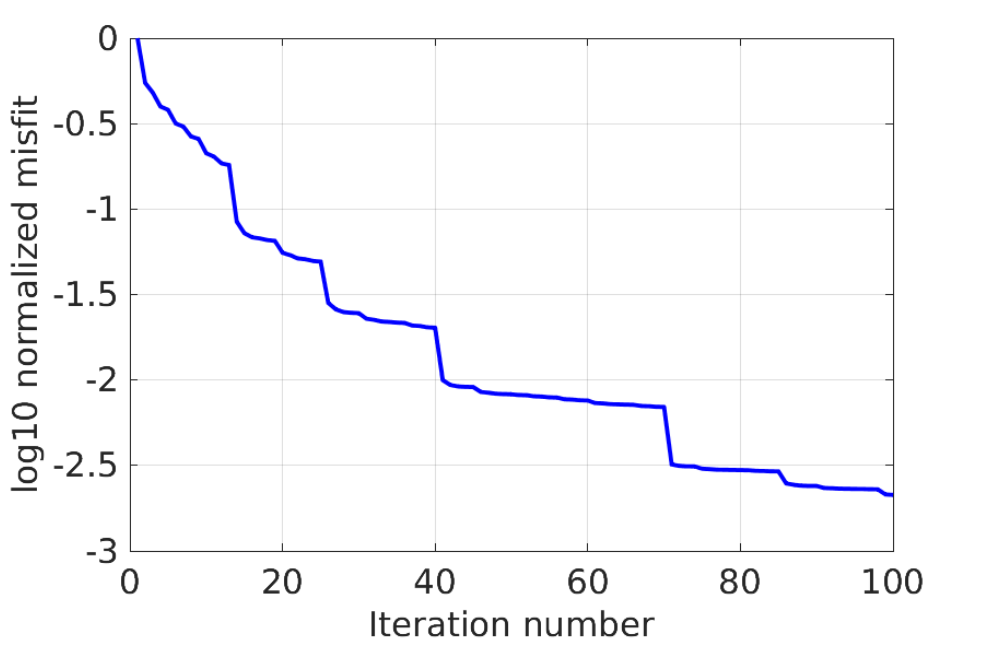
Figure 8. A step-wise decrease in the objective